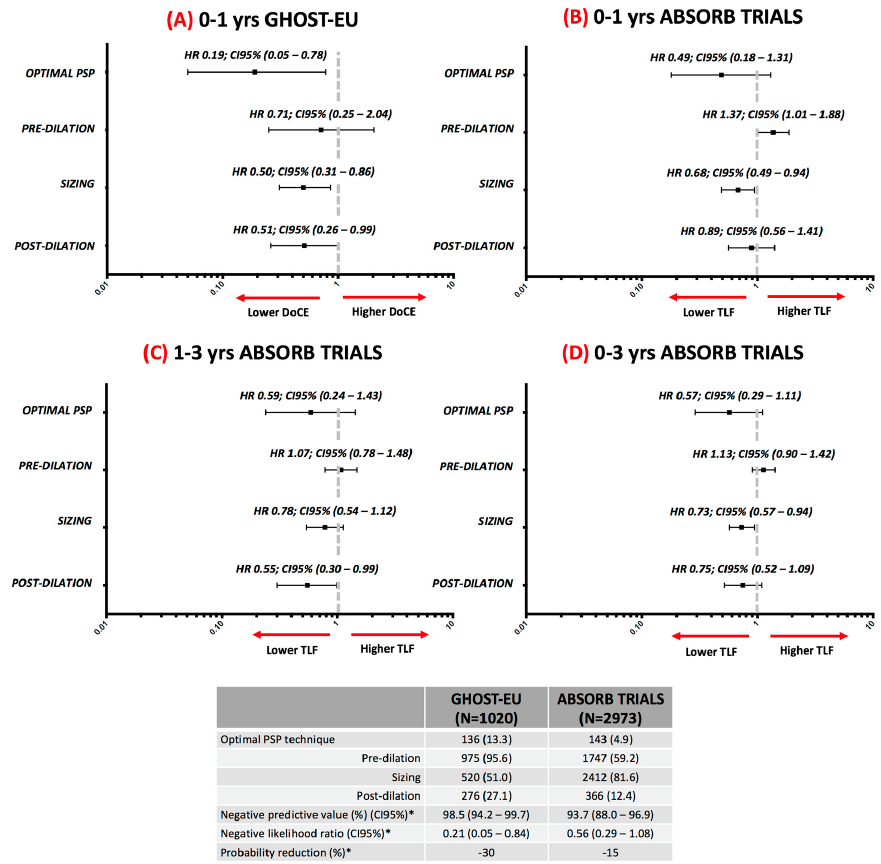
Figure 2. Impact of PSP technique on device-oriented composite endpoint following bioresorbable scaffolds implantation. HR and 95% CI values of the GHOST-EU trial were adapted from [8] and of the ABSORB trials were adapted from [10]. * Predictive values and likelihood ratio for GHOST-EU is calculated at 1-year and for ABSORB trials at 3-years. DoCE and TLF are defined in Table 2. HR: Hazzard ratio; CI: Confidence Interval; DoCE: device-oriented composite endpoint; TLF: Target Lesion Failure.